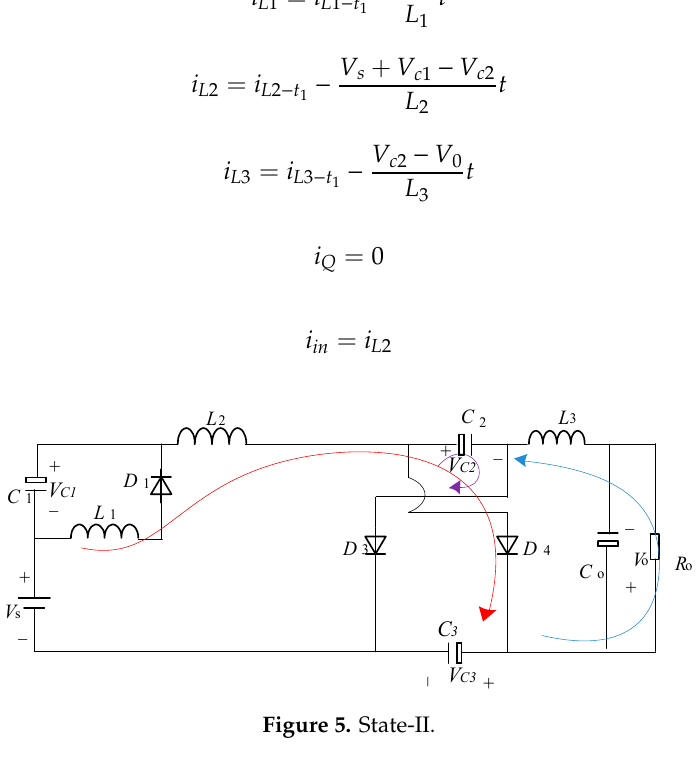
Energies 2020 , 13 , x FOR PEER REVIEW